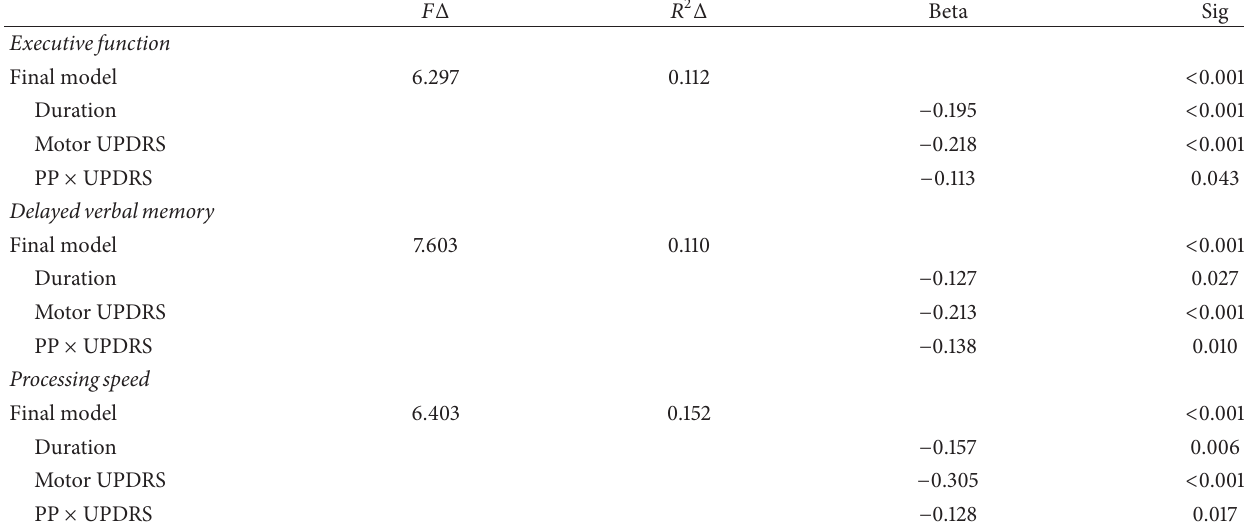
Table 4: Pulse pressure and cognitive domains: summary of results of hierarchical multiple regression analyses.